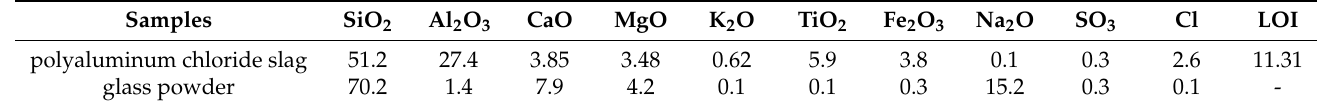
Table 1. The chemical composition of raw materials (wt/%).